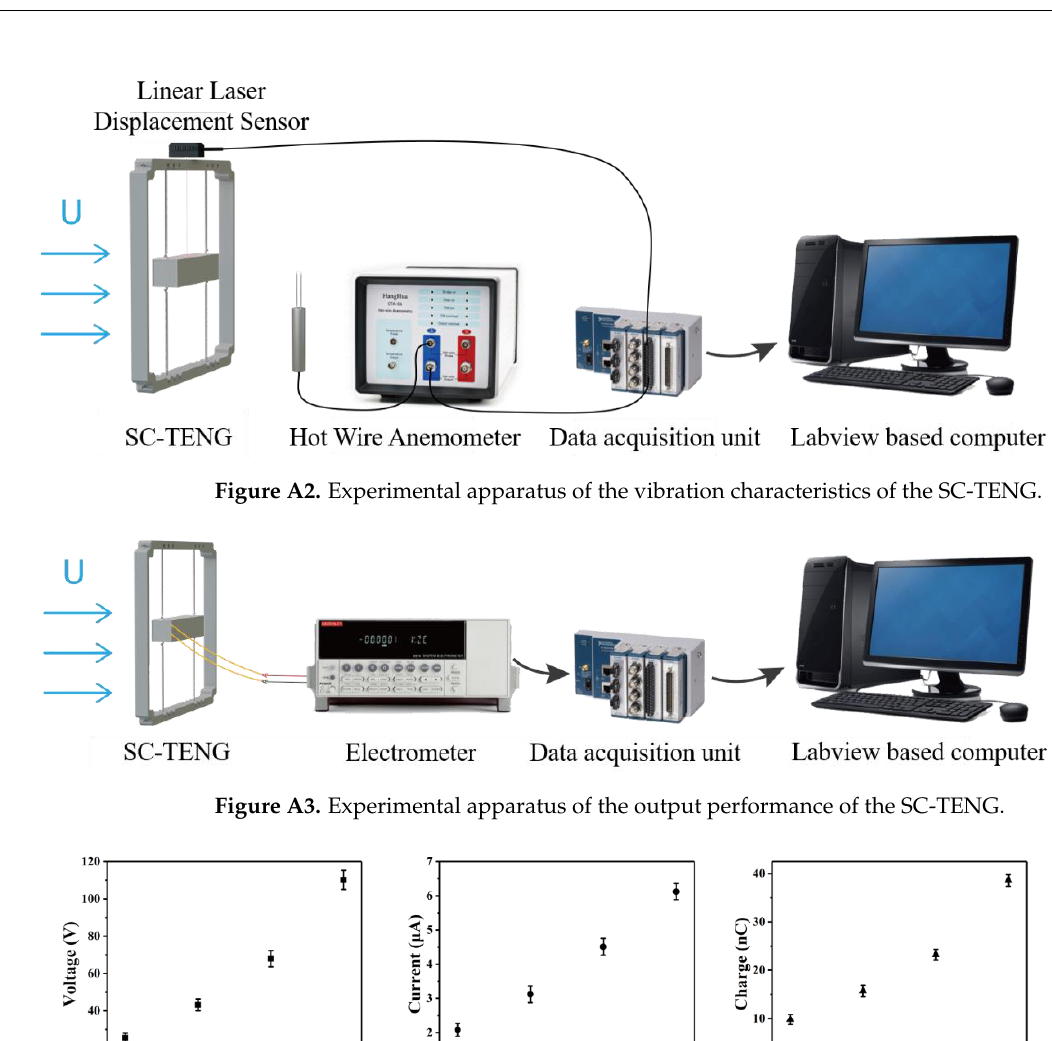
Figure A1. Comparison of the number of PTFE balls accommodated between square-grid structure and honeycomb structure.